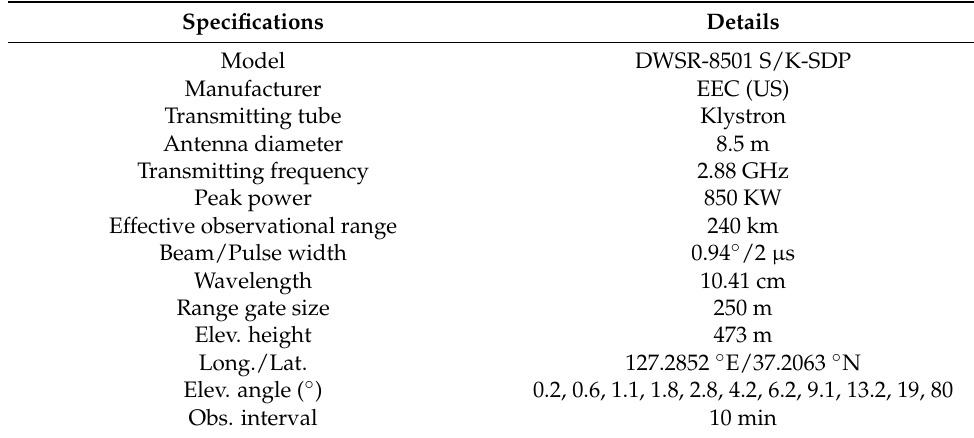
Table 2. Specifications of YIT.